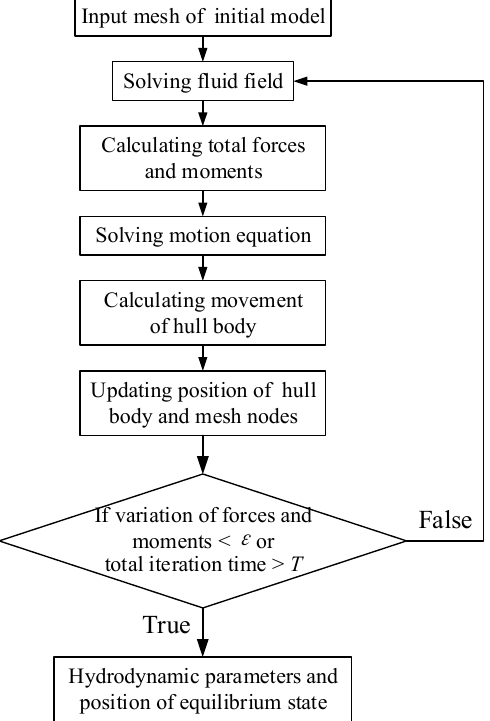
Figure 6. Solver procedure of the numerical method.